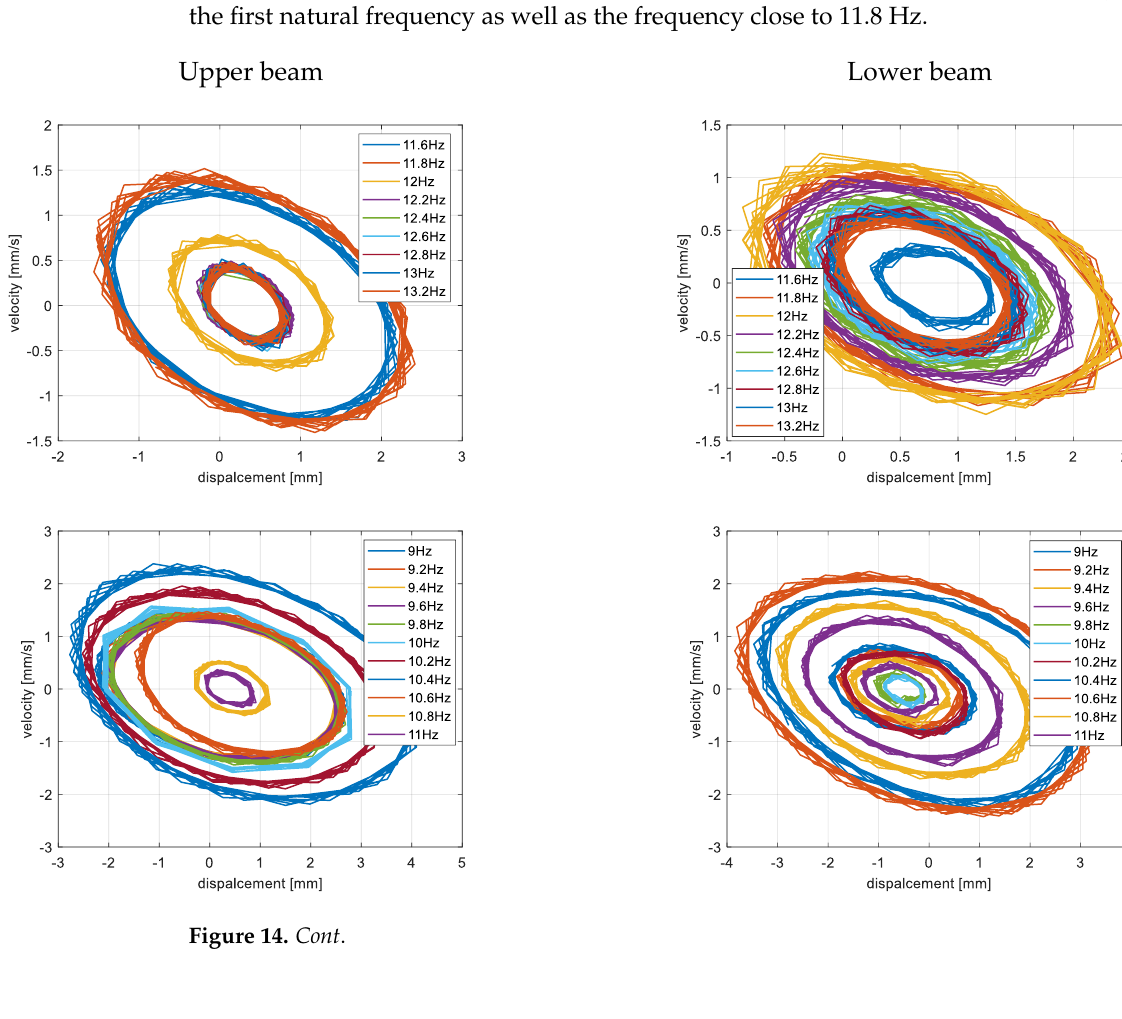
Figure 13. The comparison of the efficiency of real magnetic coupled harvesters by various beam spaces in the structure.